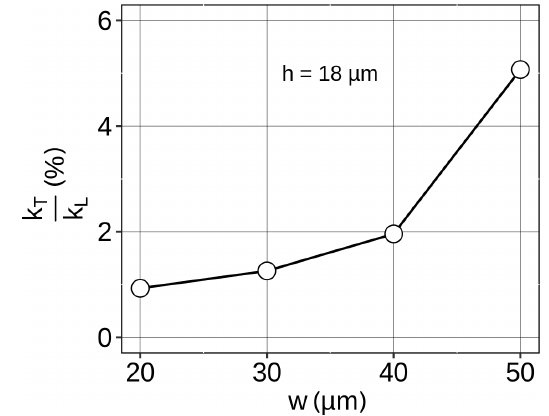
Figure 7. The graph illustrates the influence of the path width on the k T /k L ratio of highly sensitive strain gauges. The path height was fixed at 18µm.